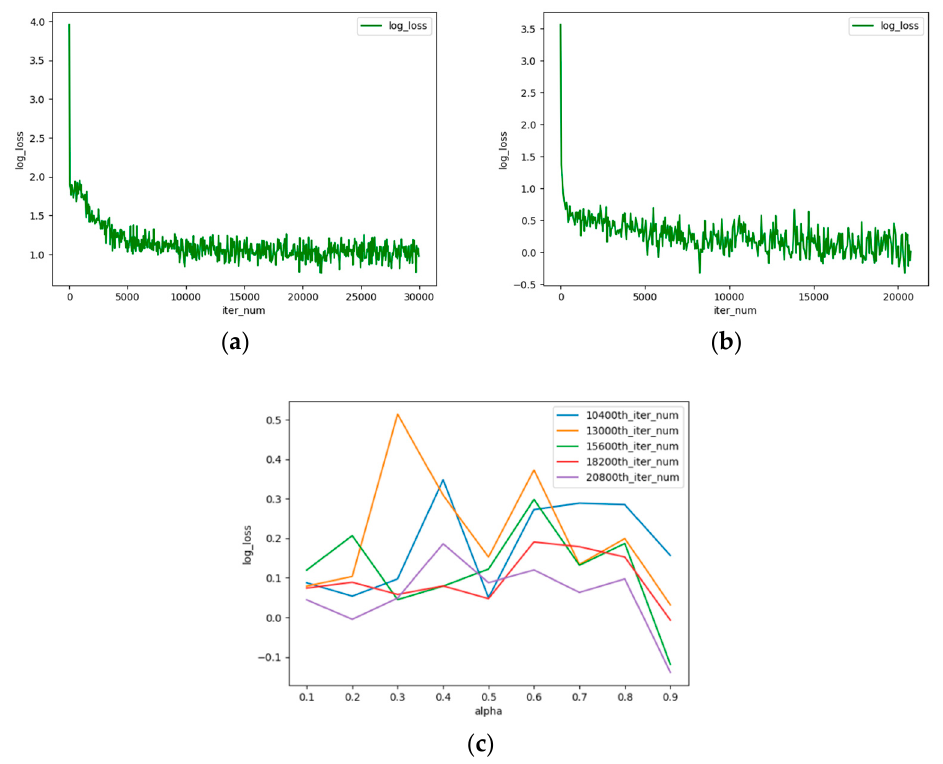
Figure 4. Logarithm of loss curves in our methods. ( a ) The logarithm of loss curve in the pre-trained model. ( b ) The logarithm of loss curve in the post-trained model. ( c ) The logarithm of loss curve as function of α at different iteration steps in the post-trained model.